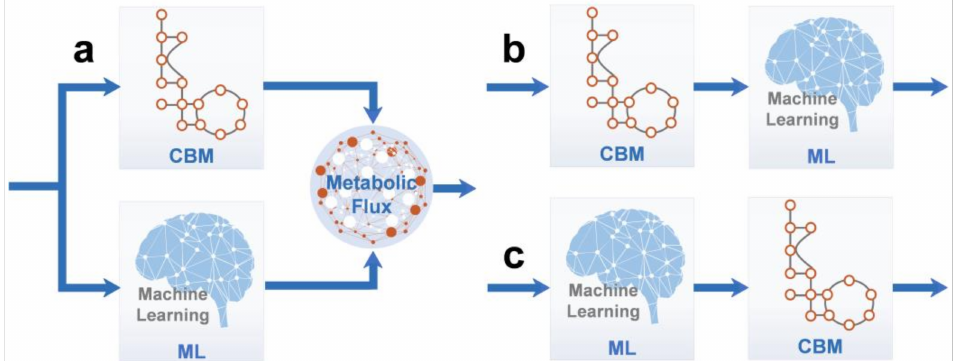
Figure 3. Different forms of CBM and ML integration. ( a ) Processing omics data and predicting parameters using ML. ( b ) Obtaining more biological insights from the metabolic flux date using